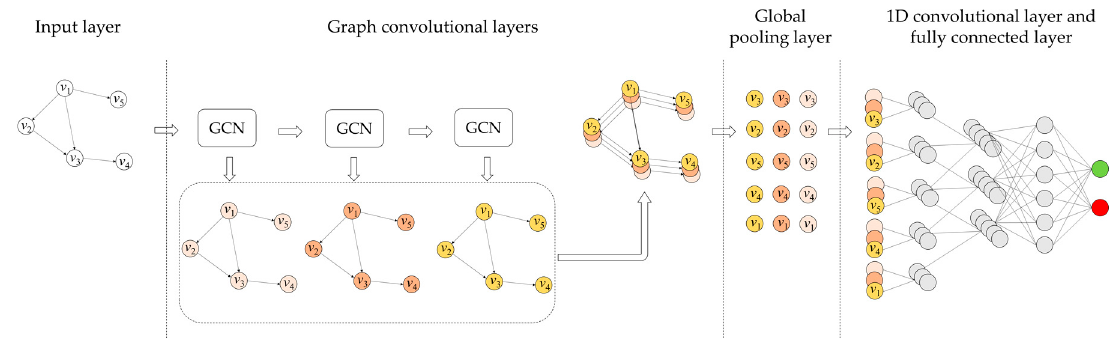
Figure 5. Overview of the model of deep graph convolutional network.